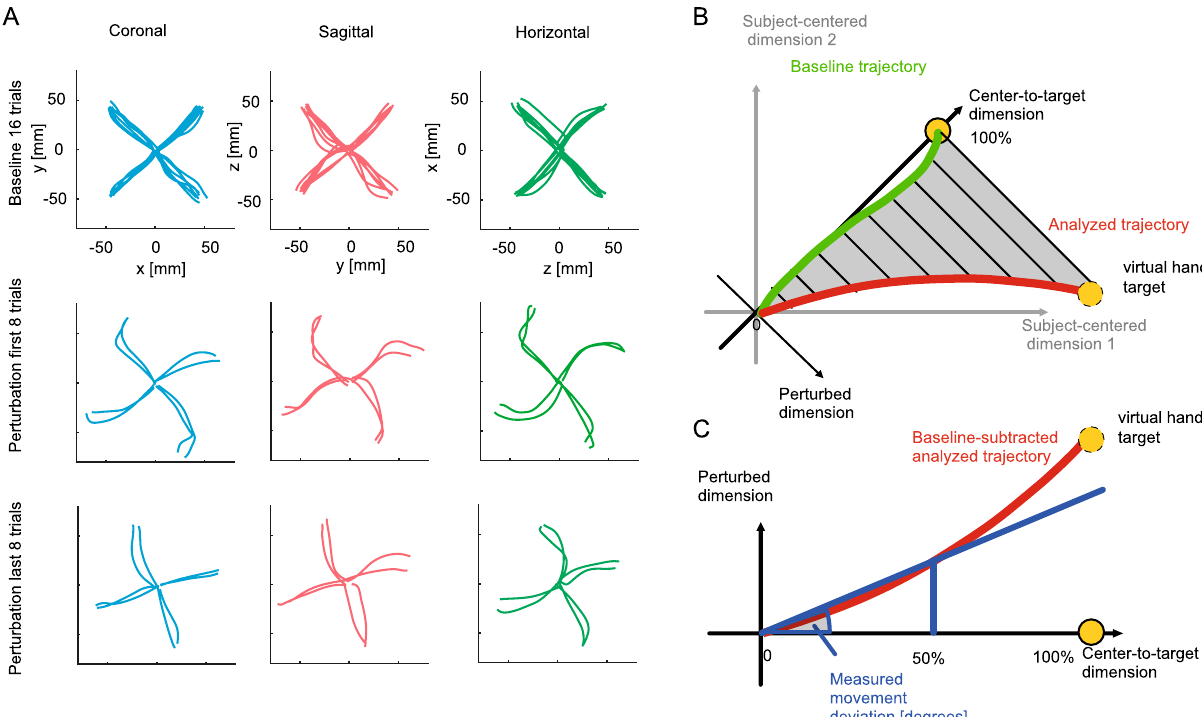
Figure 2. Quantification of adaptation level. ( A ) Example trajectories from one subject. Each row/color of the graph corresponds to different planes of rotation. The trajectories are projected onto the plane which is perpendicular to the axis of visuomotor rotation for representation and analysis of the data in each of the three conditions (coronal, horizontal, sagittal). The trajectories show similarities across the three planes. ( B ) Within each plane, the trajectories are quantified along the two task relevant dimensions, the center-to-target dimension and the dimension orthogonal to it in the same plane, which we refer to as “perturbed” dimension. To compare data across tasks, each trajectory was resampled and rotated into this reference frame. At half of the normalized trajectory, the adaptation angle was calculated and used for model fitting. In this schematic representation, the subject-centered dimensions refer to the original movement axis (x, y or z) and define the original horizontal, sagittal or coronal planes of the setup. Movements are represented relative to task-relevant dimensions. The virtual target indicates the direction which would correct for the perturbation if movements were re-aimed at. ( C ) Examples of transformed trajectories from one subject during late